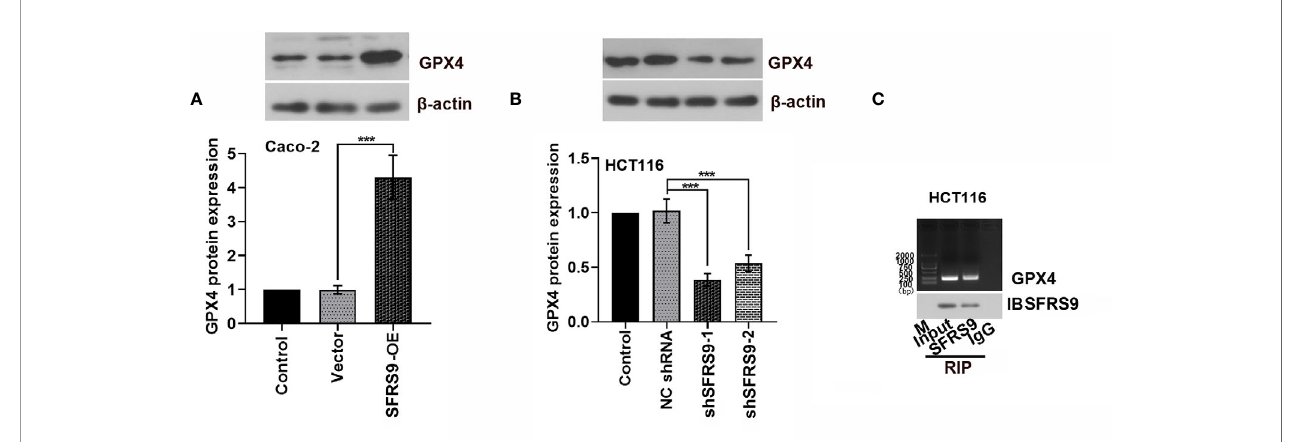
FIGURE 6 | SFRS9 regulation of GPX4. (A) Protein levels of GPX4 in Caco-2 cells transfected with SFRS9 OE vector. (B) Protein levels of GPX4 in HCT116 cells transfected with SFRS9 shRNAs. (C) RNA immunoprecipitation assay was performed to evaluate the interaction between SFRS9 and GPX4. Values are mean ± SD. ***p <